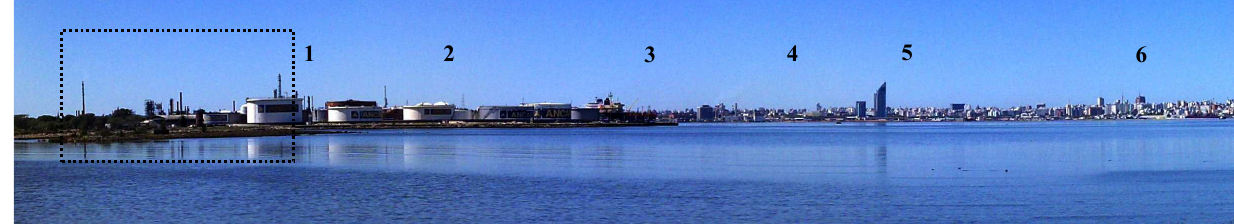
Fig. 2. Panoramic view of the oil refinery and the Montevideo Bay from the measuring site. The dashed rectangle indicates the emitting stack group. The cross scanned sections are numbered from 1 to